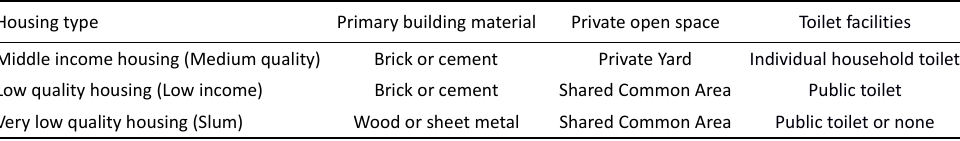
Table 1: Housing types and characteristics depend on the criteria of quality Table 1. Housing types and characteristics depend on the criteria of